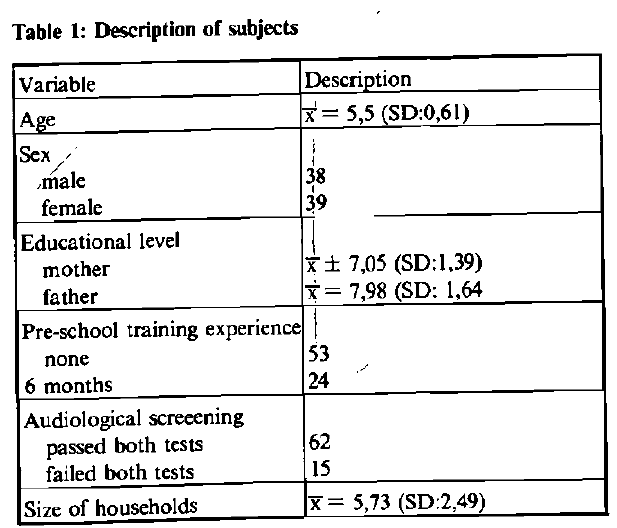
Table 1: Description of